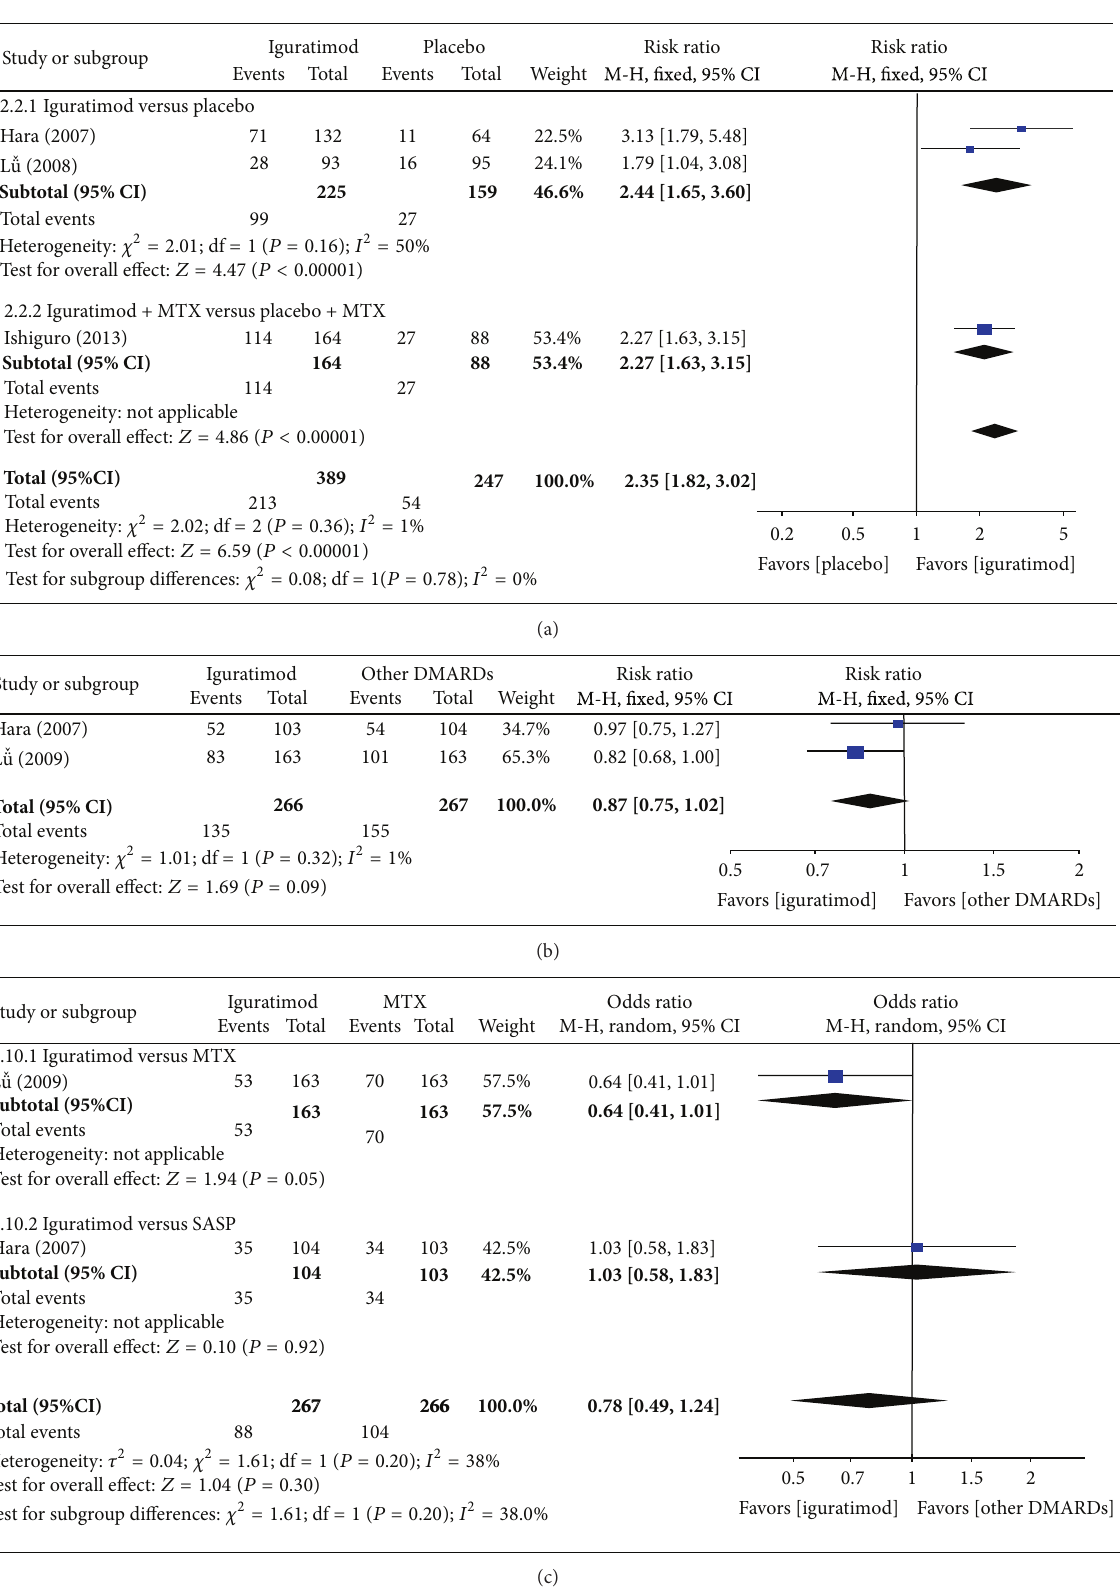
Figure 4: (a) Comparison of ACR20 at 24 weeks between iguratimod and placebo groups. (b) Comparison of ACR20 at 24 weeks between iguratimod and other DMARDs (MTX and SASP) groups. (c) Comparison of ACR50 at 24 weeks between iguratimod and other DMARDs (MTX and SASP)